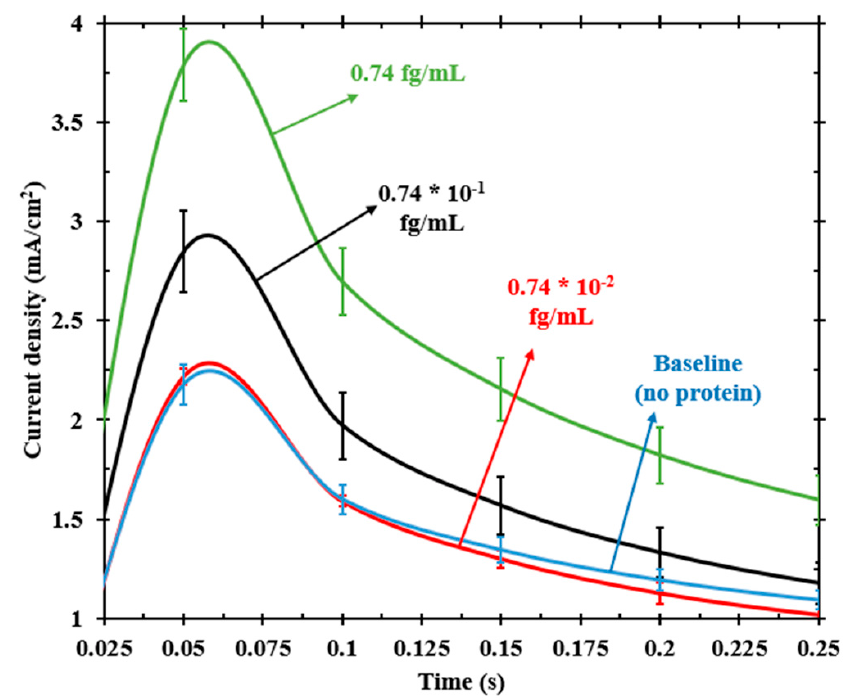
Figure 8. Chronoamperometry plot showing the successful detection of a samples containing 0.74 fg/mL and 0.074 fg/mL (detection limit) SARS-CoV-2 spike protein, while the currents from a 0.0074 fg/mL sample overlap with the baseline and indicates no detection.